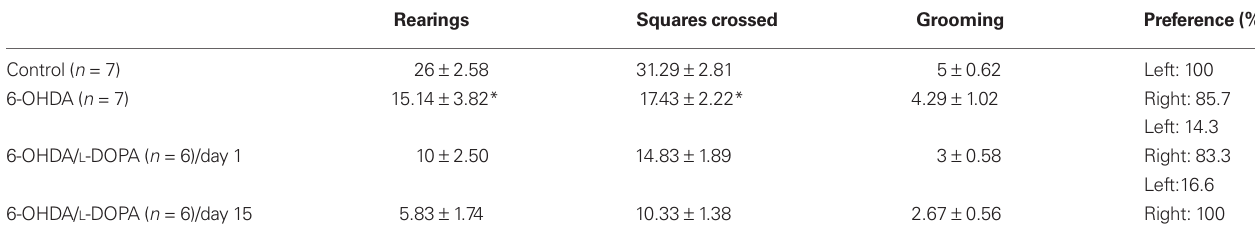
Numbers are mean ± SEM. *p < 0.05 vs control (paired